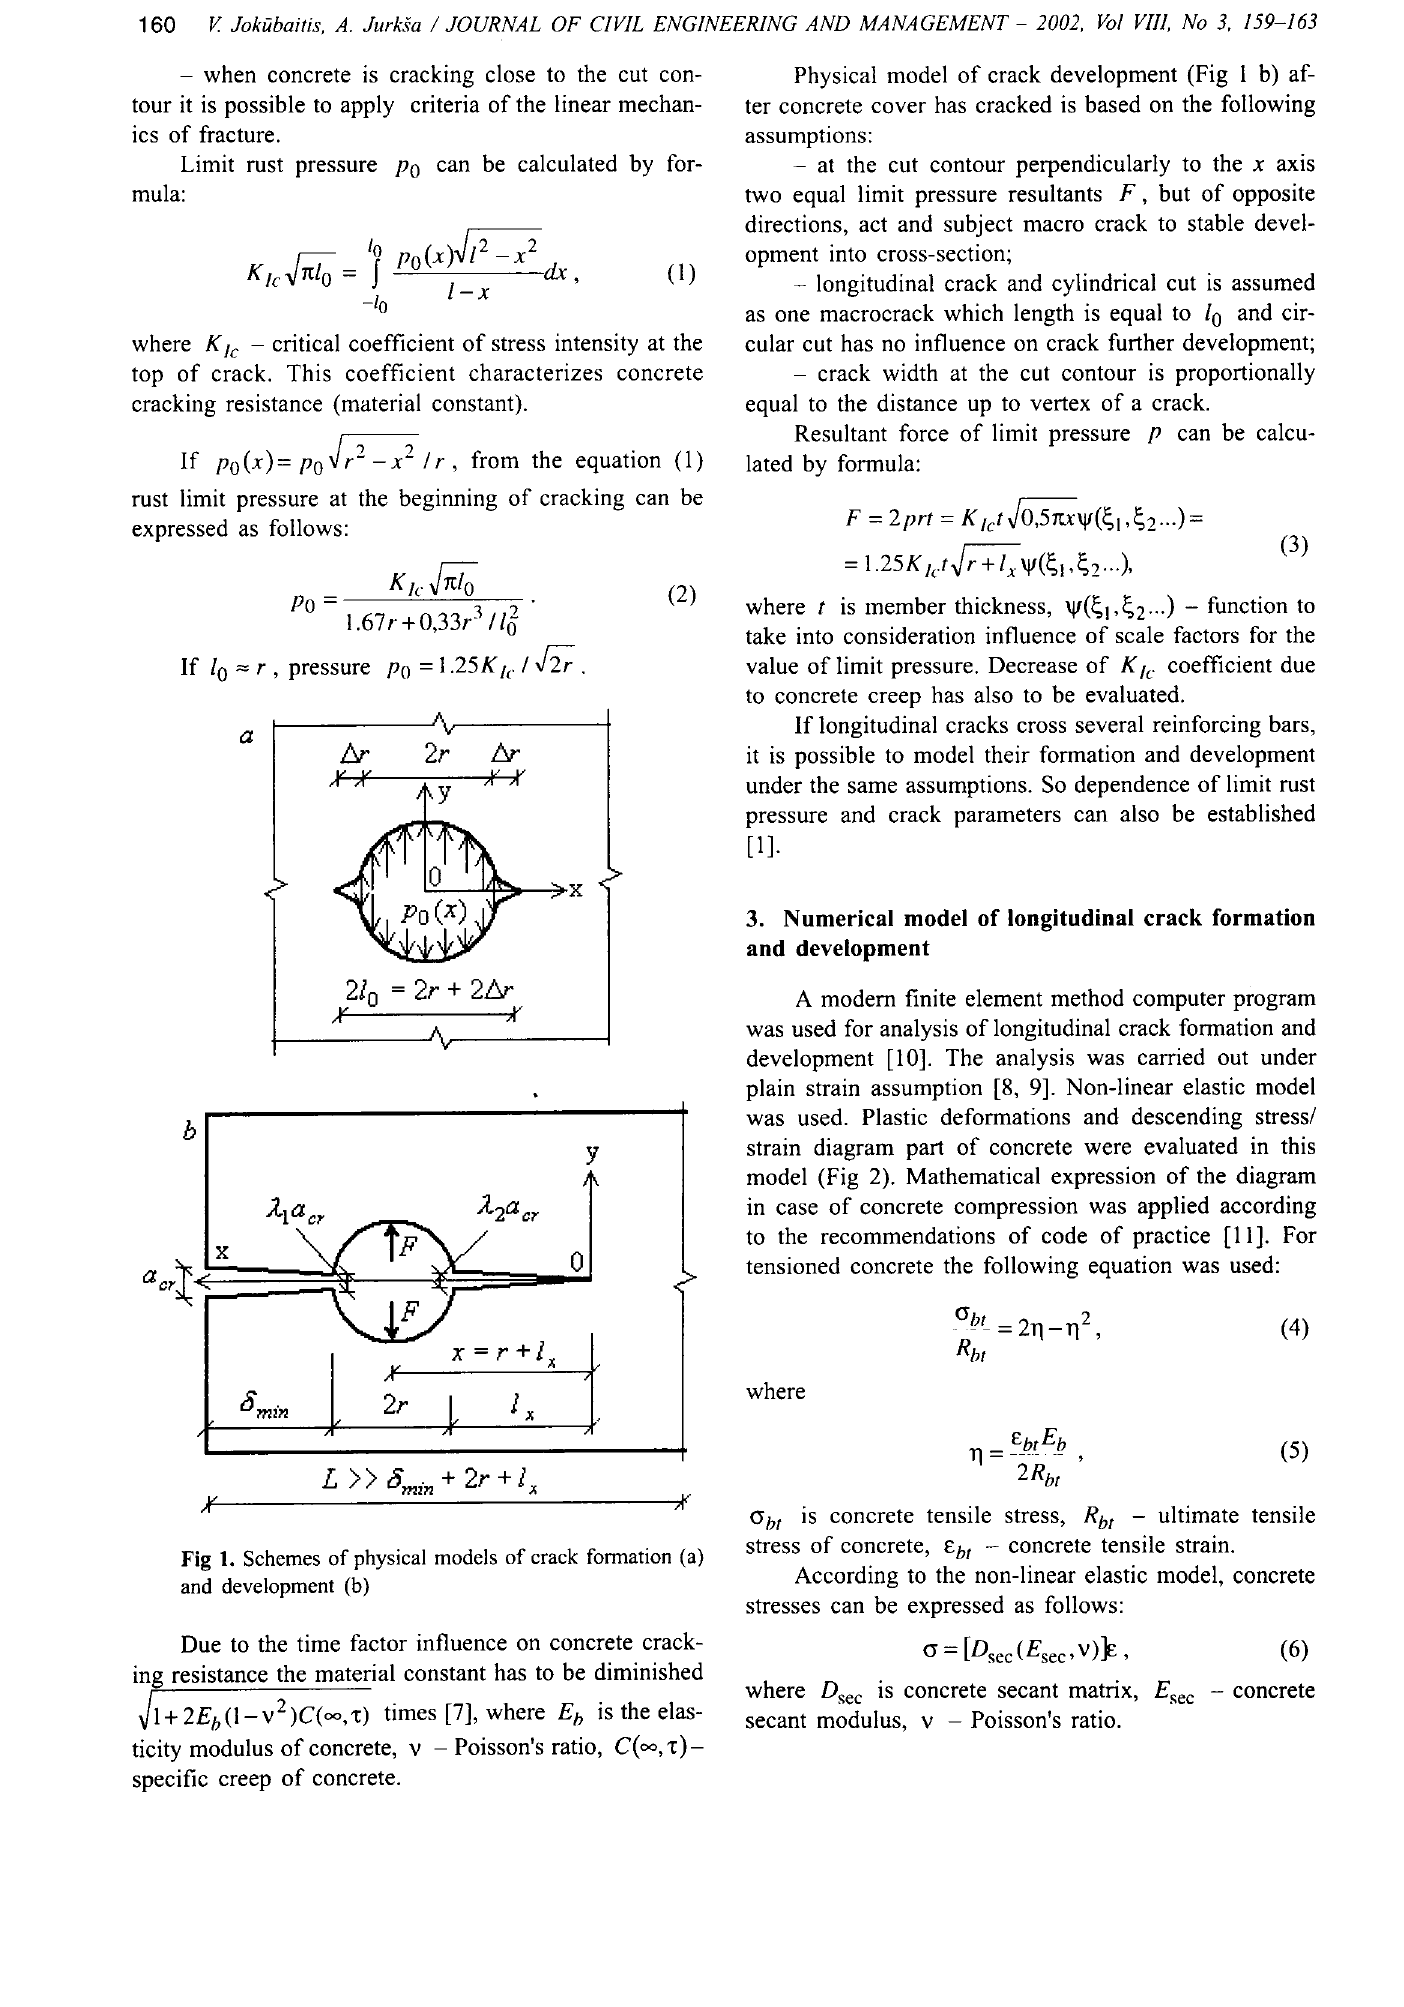
Fig 1. Schemes of physical models of crack formation (a) and development